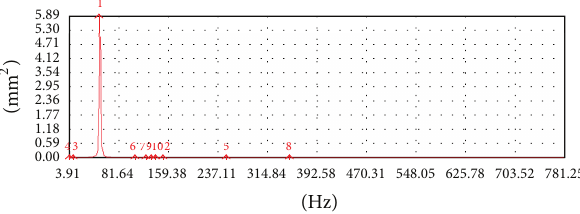
Figure 12: Frequency domain of the wingtip’s dynamic response of an uncontrolled SMA composite wing when the mean wind velocity 𝑉 = 6